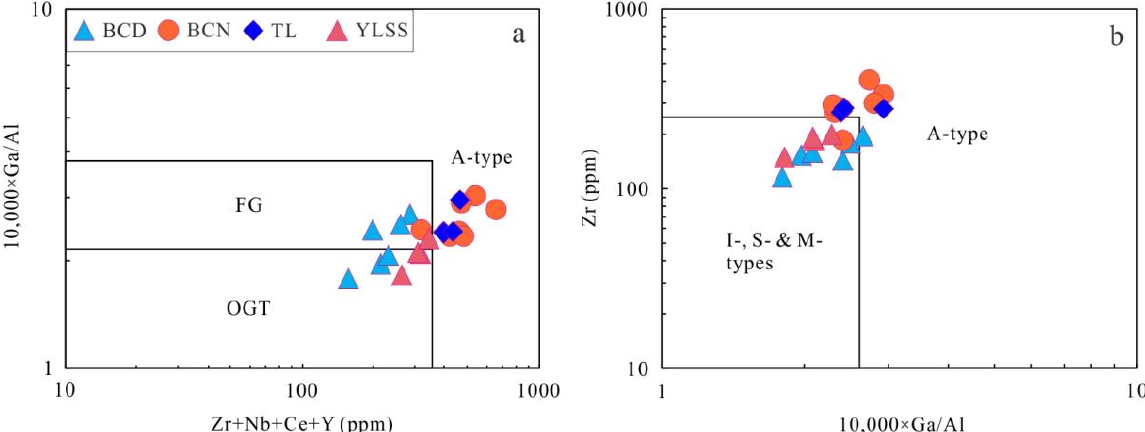
Figure 10. Plots of 10,000 × Ga/Al versus (Zr + Nb + Ce + Y) ( a ) and Zr ( b ) [98] for the Yilashan and Amdo granitoids in the Nagqu area. Symbols as in Figure 6. FG: fractionated felsic granites; OGT: unfractionated M-, I- and S-type granites.